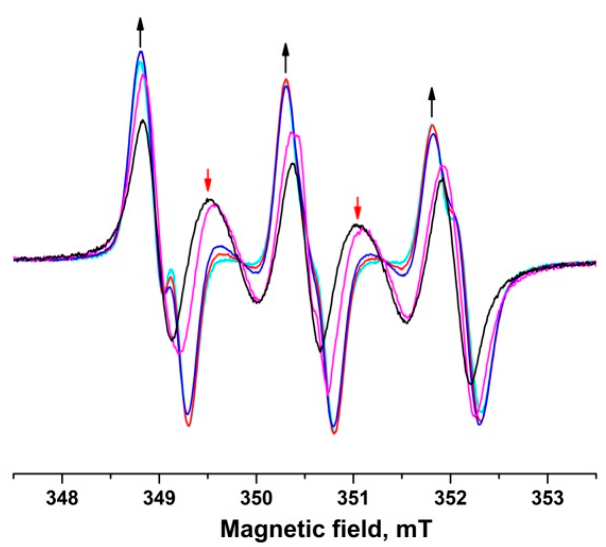
Figure 7. Kinetics of the decay of nitroxide biradical 4 in the presence of 0.1 M ascorbate in PBS at pH 7.4.